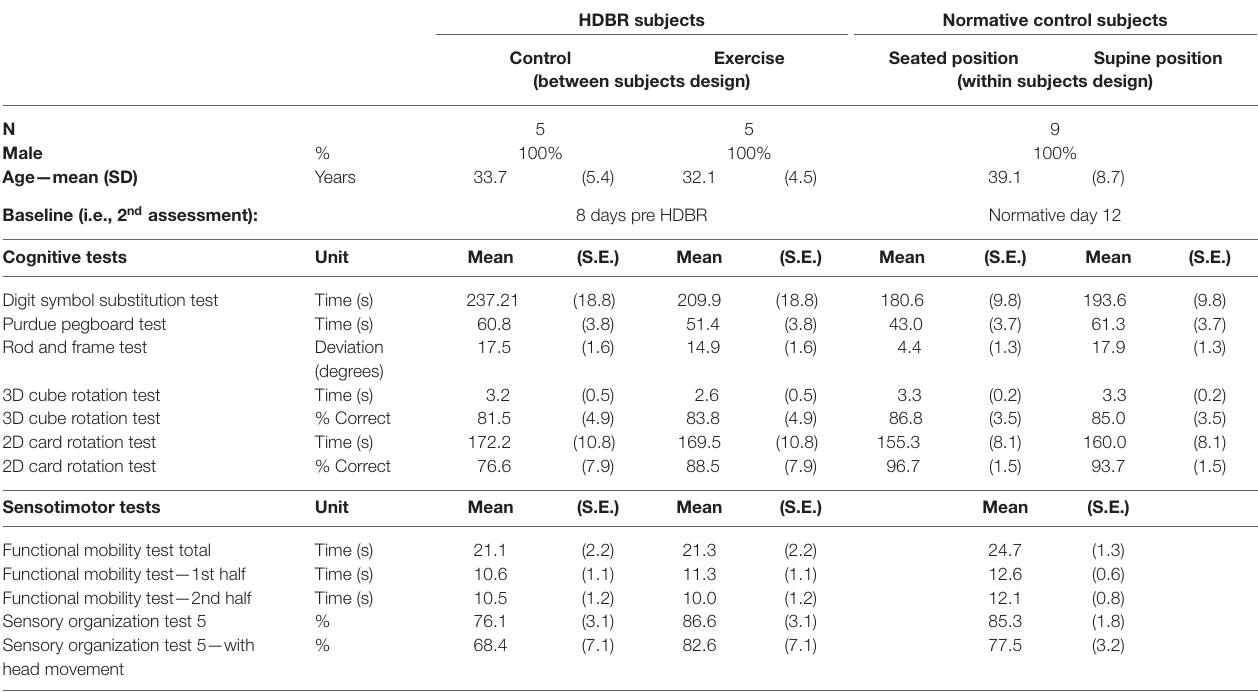
TABLE 1 | Demographics and baseline scores for bed rest subjects and normative control